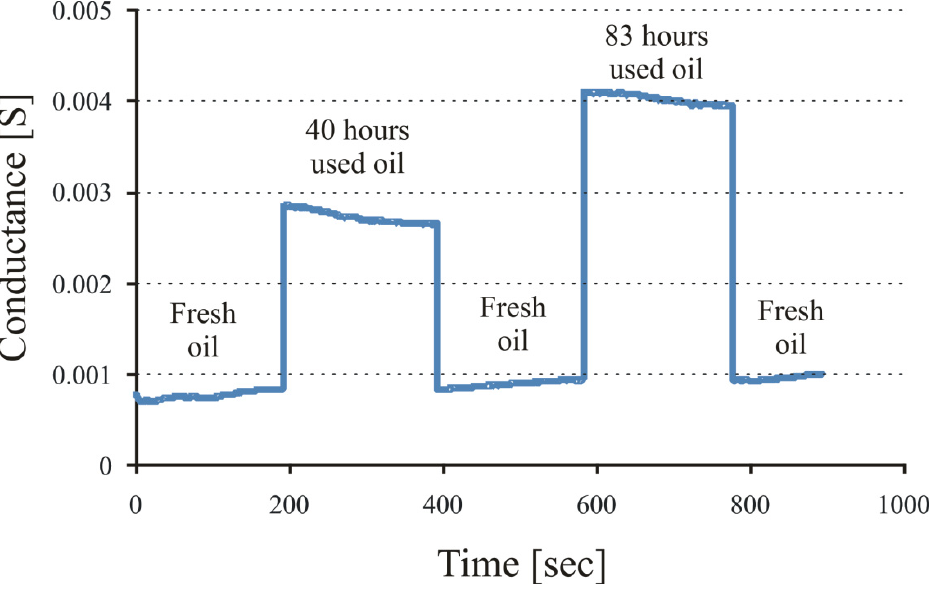
Figure 9. Conductance of polyurethane-nanotubes composite while exposing to fresh and used oil samples at 80